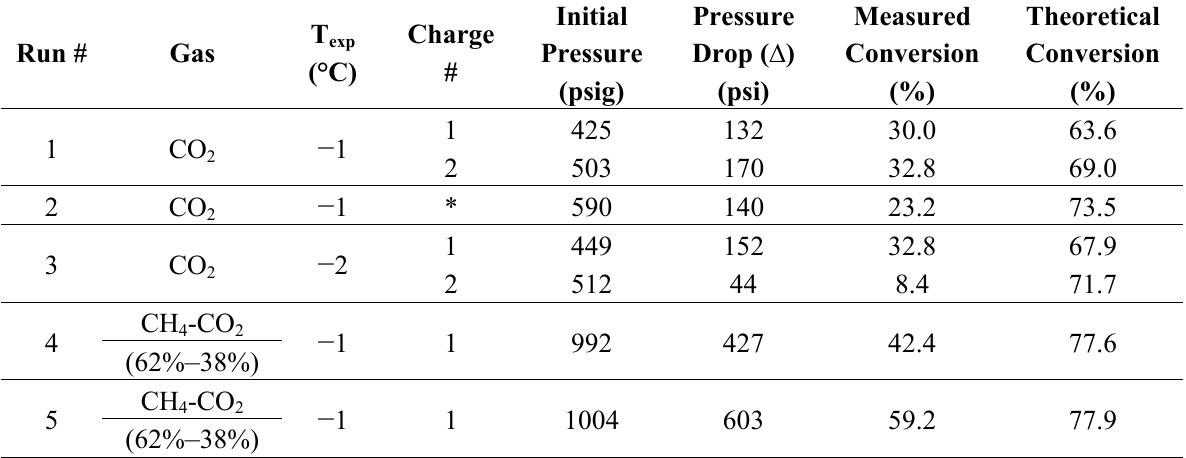
1. Experimental Conditions and Results from Runs in the FISH